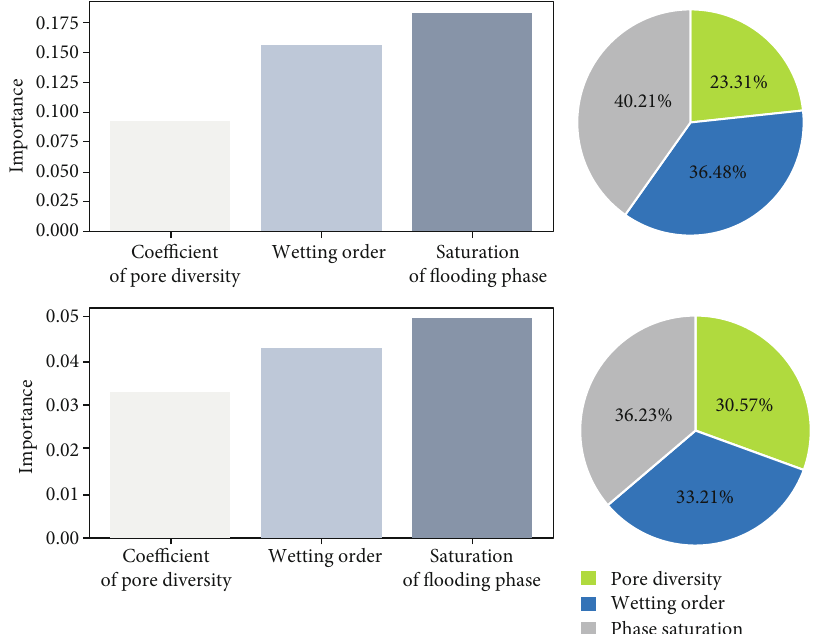
Figure 7: Two-phase relative permeability obtained from micro fl uidic experiments.